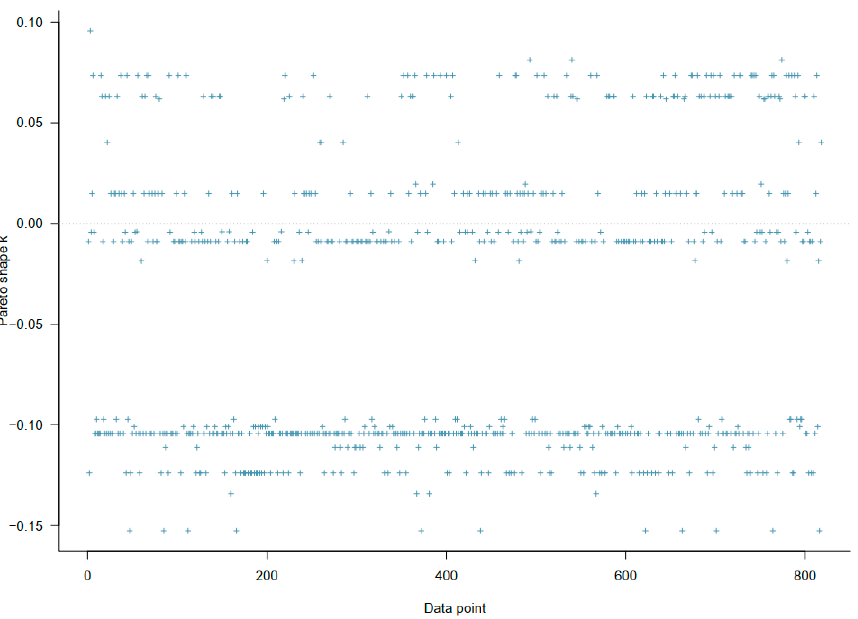
Figure 7. Model 3 ′ s PSIS diagnostic plot. Figure 7. Model 3’s PSIS diagnostic